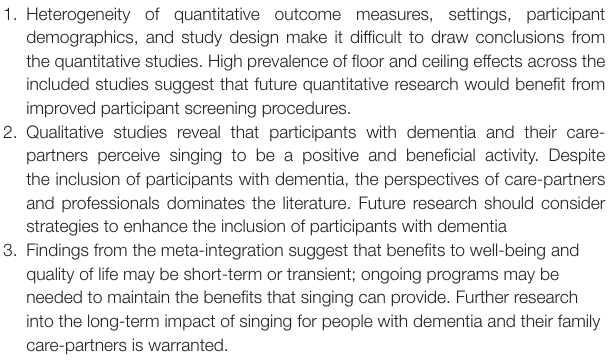
TABLE 11 | Summary of key findings and